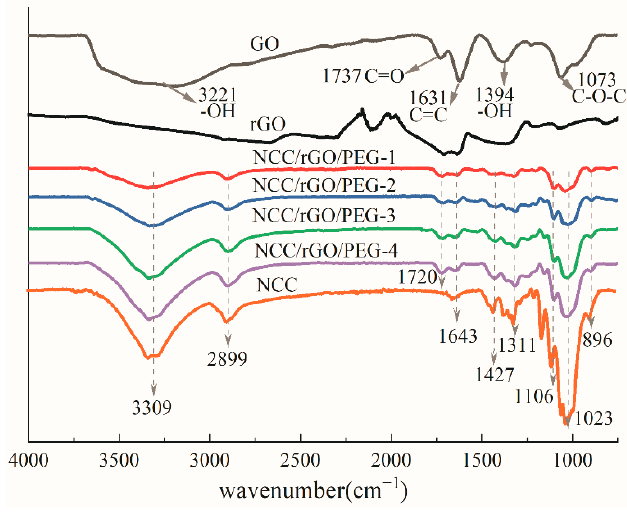
Figure 3. FTIR patterns of sample NCC, GO, rGO and different ratios of NCC/rGO/PEG composite films.